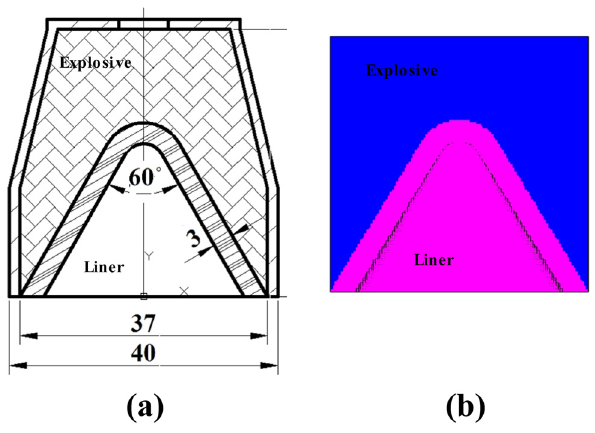
Figure 5: ( a ) Structural sketch and ( b ) scheme of a simulation model for shaped charge warhead.